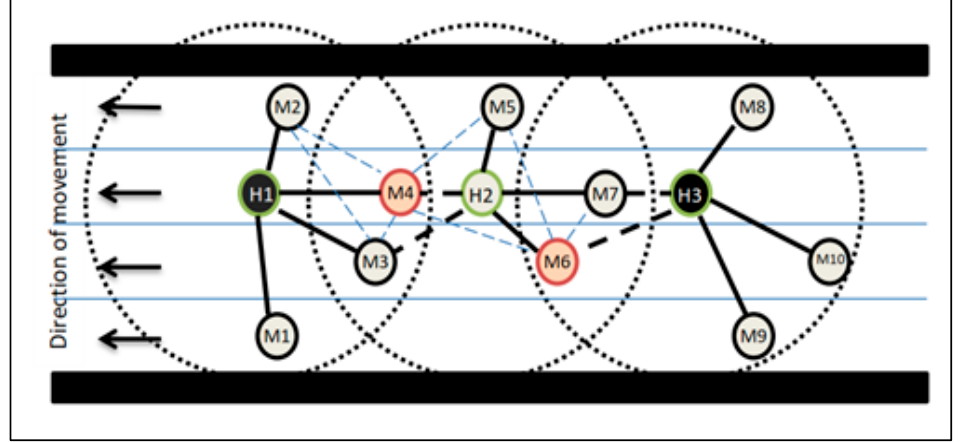
Figure 3. Cluster formation and gateway selection.